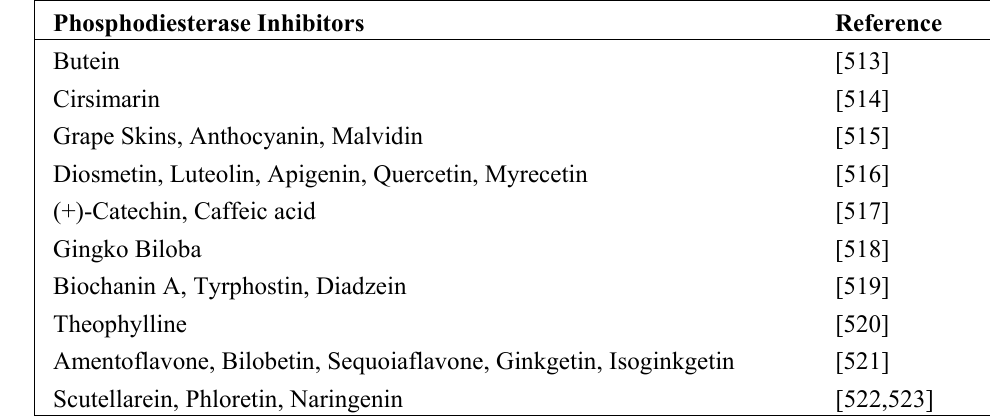
Table 10. Phosphodiesterase